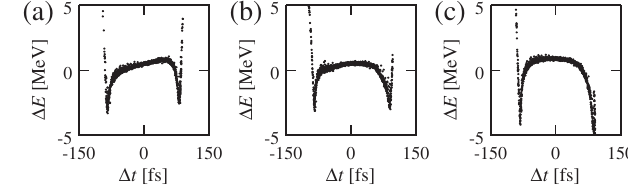
FIG. 5. Longitudinal phase space at the exit of the beam spreader for on-crest acceleration of the compressed bunch. (a) No dechirping cells. (b) Two dechirping cells, which contain a total of 16 bending magnets in four chicanes, at beam energy of 400 MeV. (c) Two dechirping cells at beam energy of 1.7 GeV.